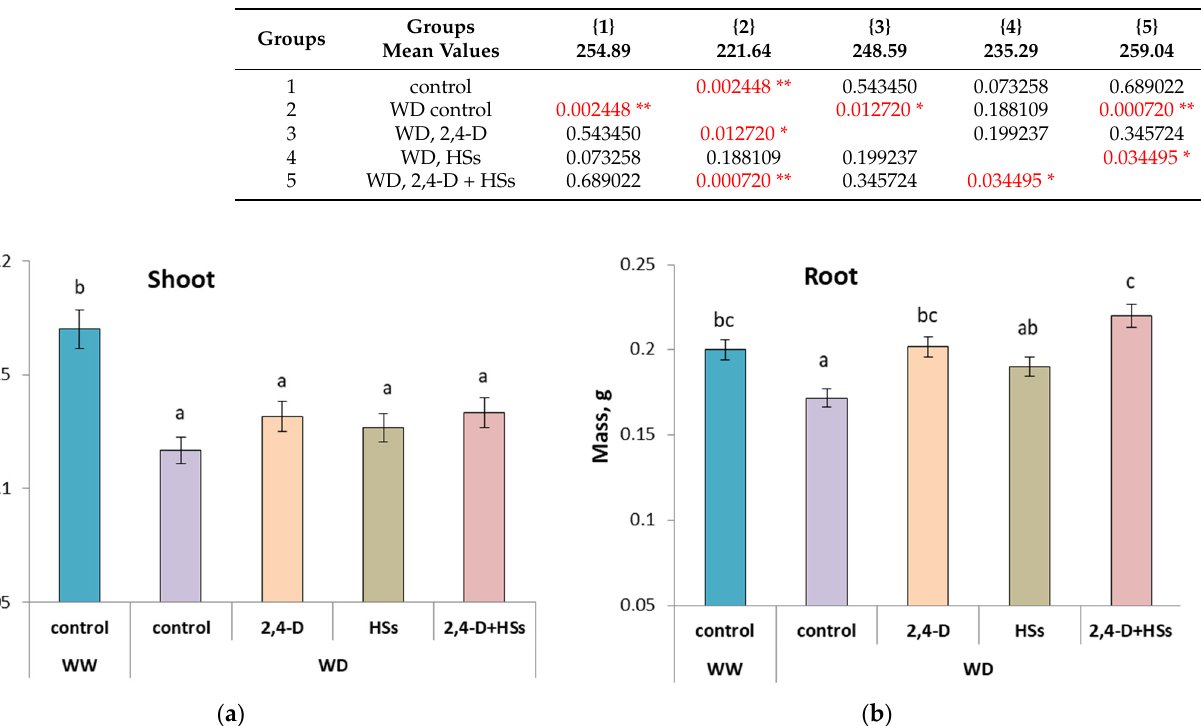
Table 2. ANOVA test for shoot length followed by Duncan test. Values in the cells correspond to p for the difference between the mean values; p ≤ 0.05 is marked with *; p ≤ 0.01—with ** for control plants untreated with either bacteria or HSs and plants grown under water deficit (WD): control, plants treated with Pseudomonas plecoglossicida 2,4 ‐ D (2,4 ‐ D), humic substances (HSs) and their combinations (2,4 ‐ D + HSs).